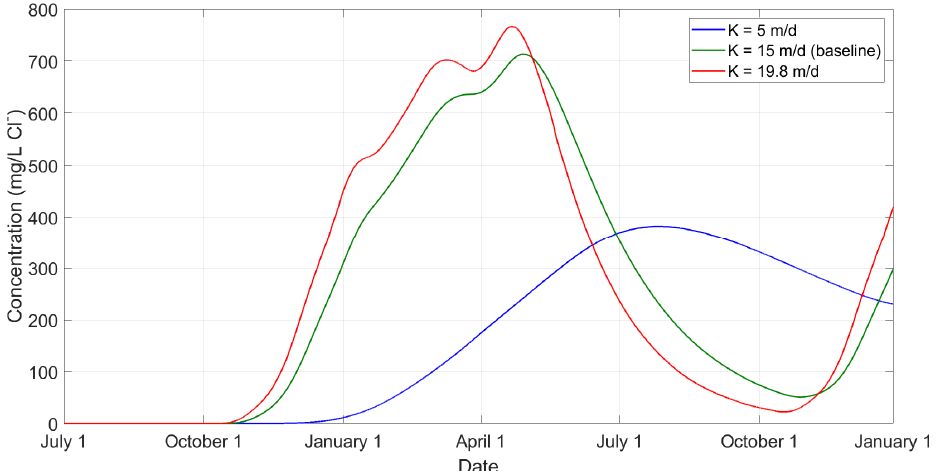
Figure 12. Concentration–time plot for the sensitivity analysis of the numerical model of salinities at the seepage face. K = 15 m/d (dark green) was the hydraulic conductivity used in the above simulations. The model is sensitive to changes in hydraulic conductivity.